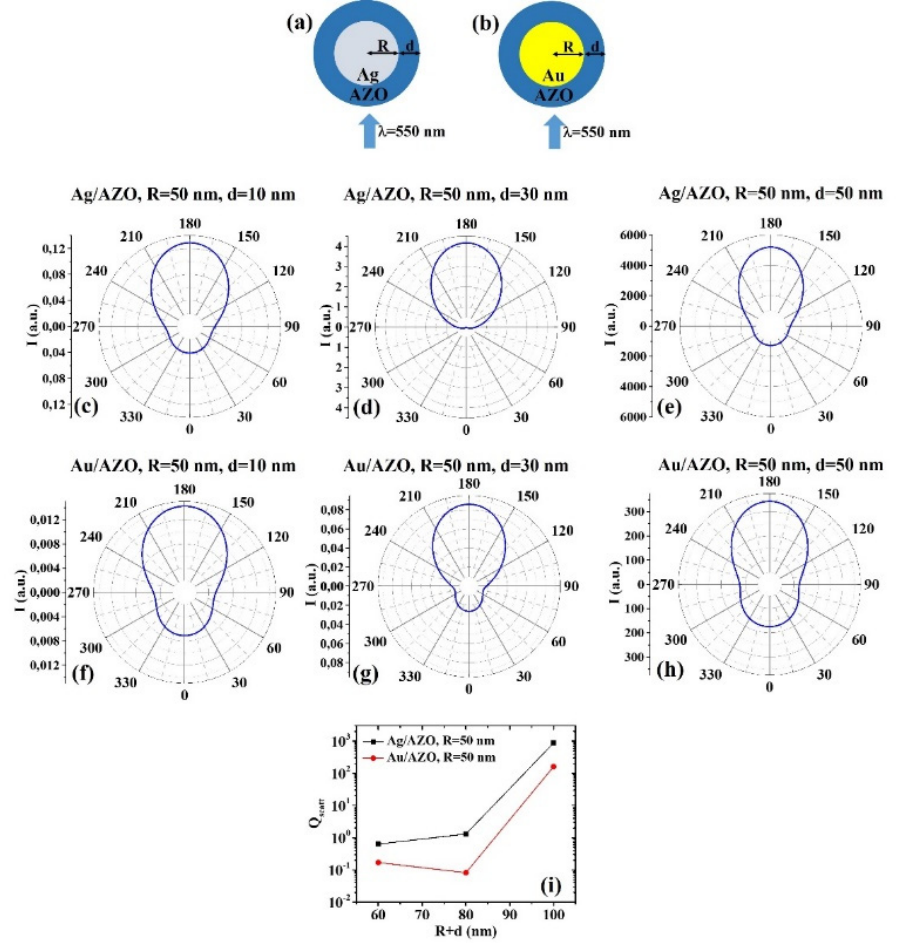
Figure 3. ( a , b ) Scheme of the structure of the simulated Ag/AZO ( a ) and Au/AZO ( b ) core–shell spherical particle with core radius R and shell width d and electromagnetic radiation of wavelength λ = 550 nm impinging on the particle from 0°. ( c – e ) Calculated polar diagrams for the intensity of the scattered light from the Ag/AZO core–shell spherical particle fixing the Ag core radius R to 50 nm and increasing the AZO shell width from 10 nm to 50 nm. ( f – h ) Calculated polar diagrams for the intensity of the scattered light from the Au/AZO core–shell spherical particle fixing the Au core radius R to 50 nm and increasing the AZO shell width from 10 nm to 50 nm. ( i ) Calculated scattering efficiency for the light (wavelength λ = 550 nm) scattering process of the Ag/AZO (black dots) and Au/AZO (red dots) core–shell spherical particles fixing the core radius to R = 50 nm and increasing the AZO shell width d from 10 nm to 50